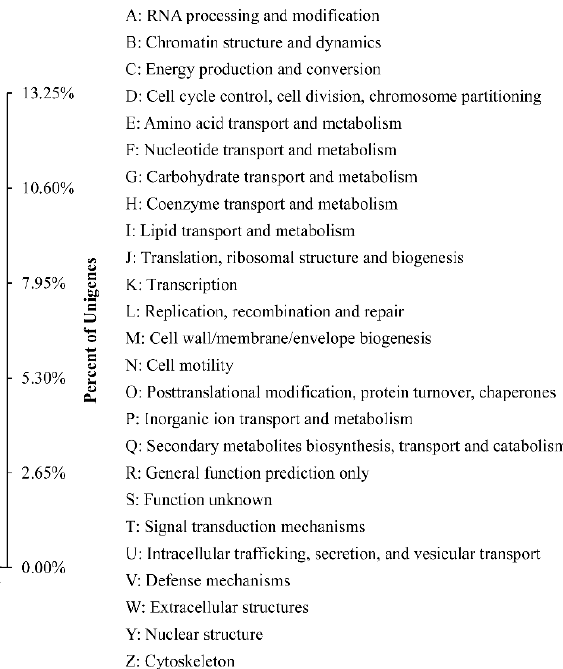
Figure 1. Clusters of orthologous groups (COG) classifications in Chinese fir. These 15,662 sequences have a COG classification within the 25